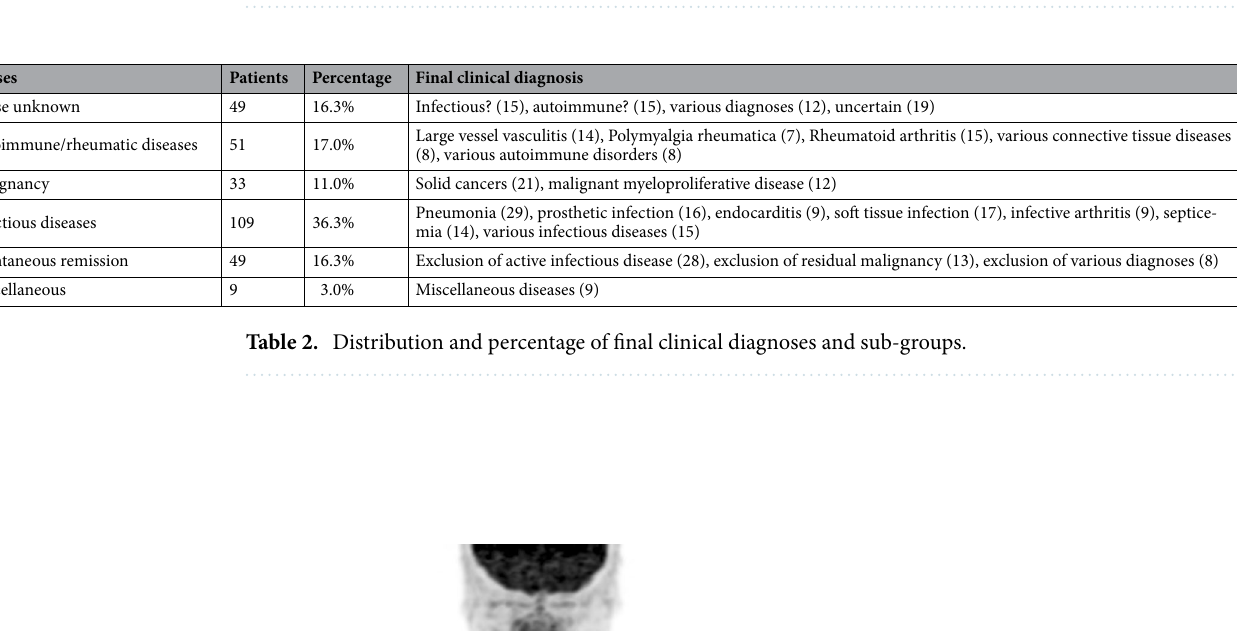
Table 1. Absolute numbers, percentage and 4 × 4 grid for sorting final diagnoses.